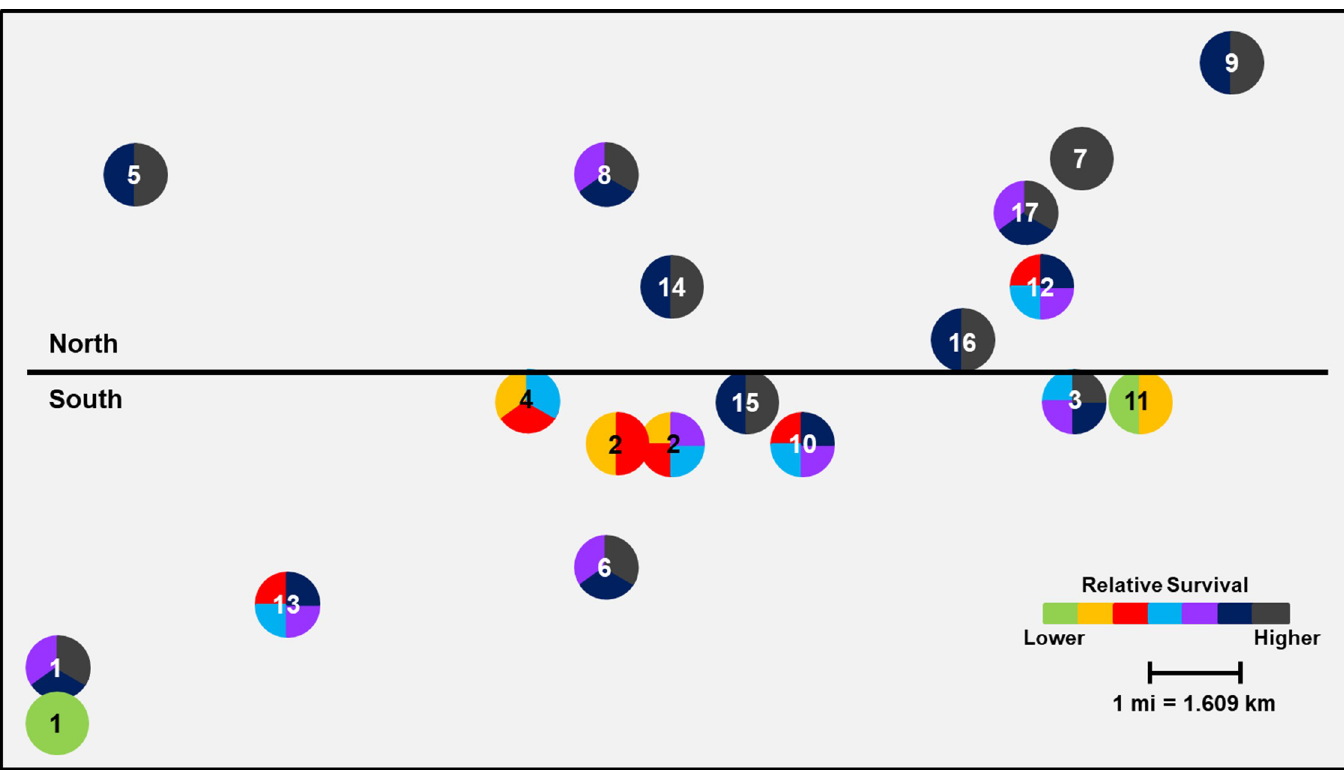
Fig 7. Spatial variation in mean mCry3A survival of WCR larvae among sampling sites in Keith County. Mean proportional survival ranged from 0.05 ± 0.01 to 0.69 ± 0.05. Circles containing the same color(s) are not significantly different (generalized linear model, P > 0.05; LSMEANS option).